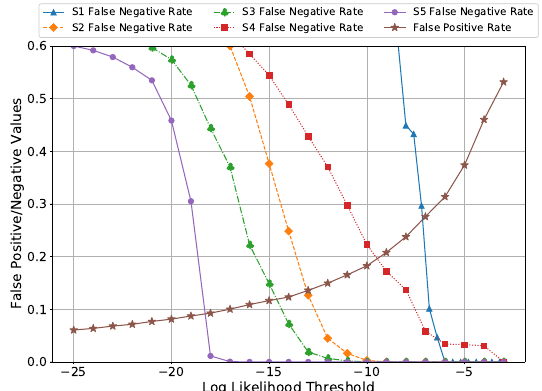
Figure 2. Experimental results for the HsMM for the attack strategy focusing on long-term requests